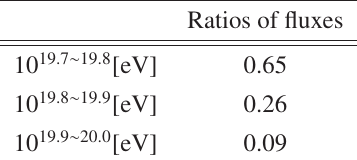
Table 2: Ratios of fluxes in three energy regions Ratios of fluxes